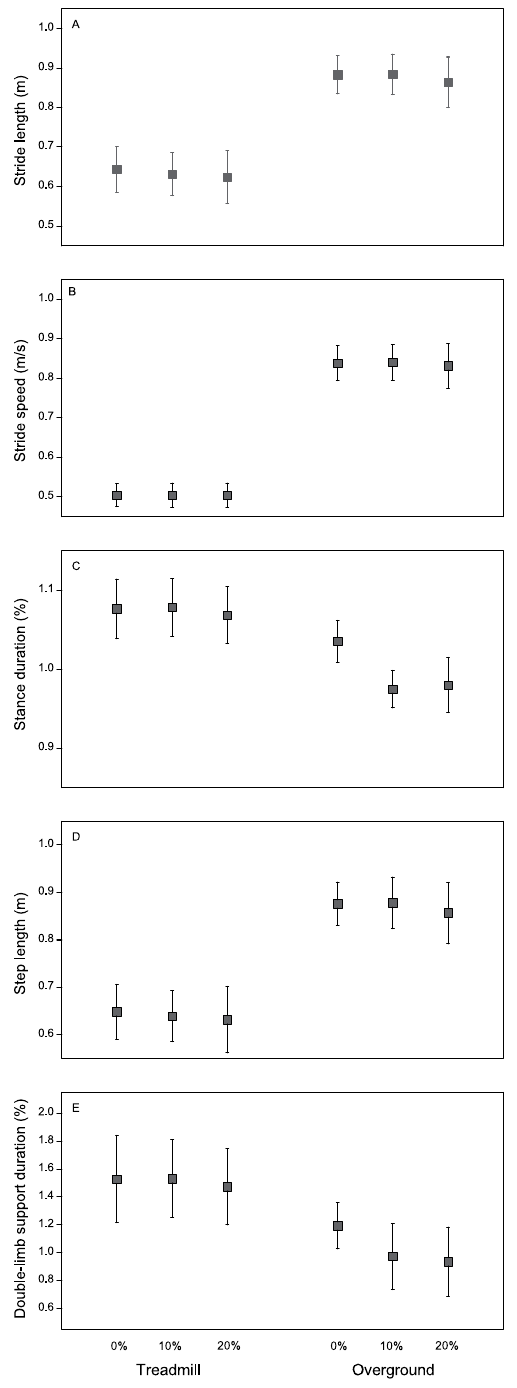
Figure 3. Mean and standard deviations for ratio of change in stride length ( A ), stride speed ( B ), percentage of stance duration ( C ), step length ( D ), and percentage of total double-limb support ( E ) at the baseline, 0%, 10%, and 20% of BWS on both treadmill and over the